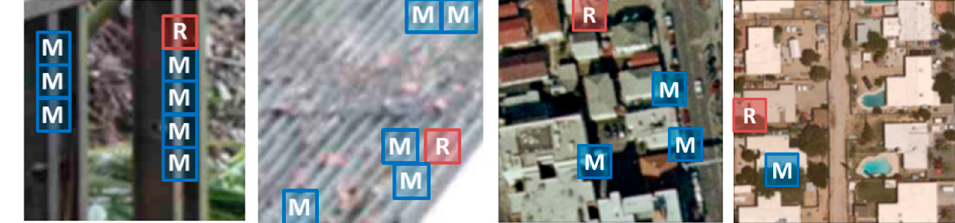
Figure 3. Illustration of grouping blocks from degraded natural images / RS scene images corrupted jointly by Gaussian blur and JPEG compression. Each fragment shows a reference block marked with “R” and a few of the blocks matched to it with “M.”.